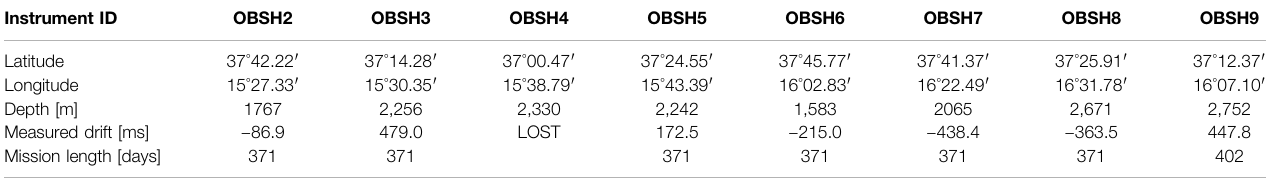
TABLE1| CoordinatesofOBSsdeployedduringtheSEISMOFAULTSsurveyandcomputedtimedriftateachinstrument.Unfortunately,theOBS4wasnotrecoveredatthe end of the experiment. Instrument